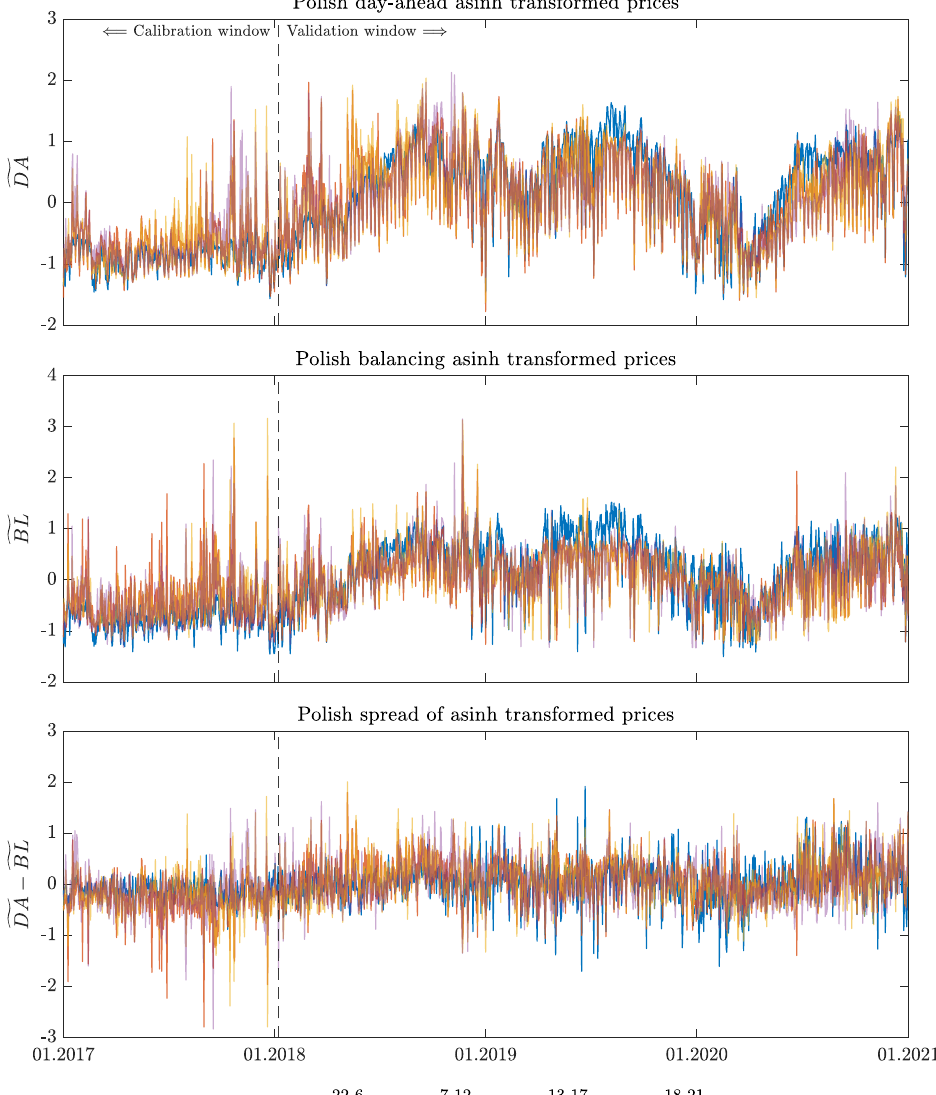
Figure A2. Polish day-ahead prices ( top panel), balancing prices ( middle panel) and the spread ( bottom panel) after the asinh transformation. For illustration the hourly prices were averaged over four representatives blocks of hours: 22–6 (night), 7–12 (morning peak), 13–17 (midday), 18–21 (evening peak). Source: Authors’